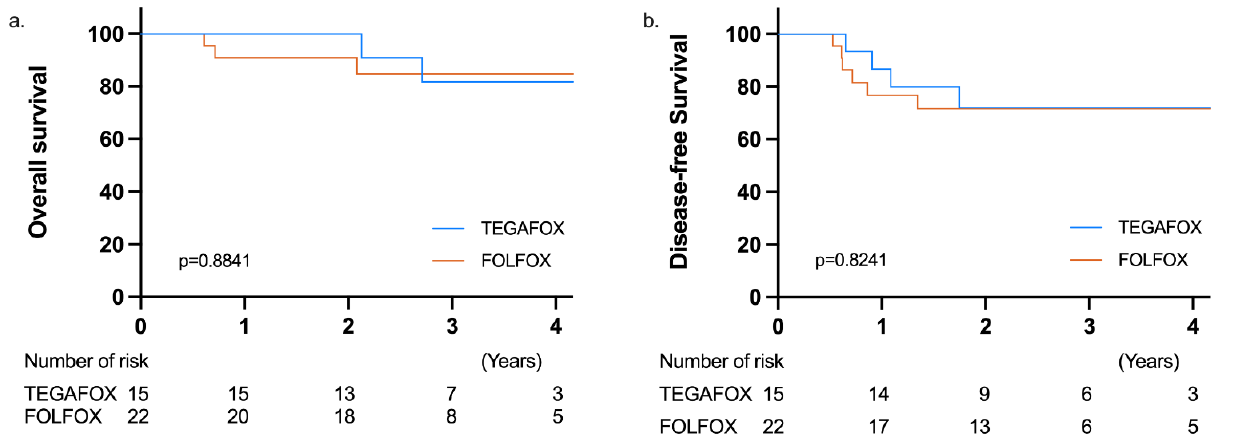
Figure 3. Comparison of Kaplan–Meier survival curves between the TEGAFOX and mFOLFOX-6 groups. ( a ) Overall survival (OS). ( b ) Disease-free survival (DFS).